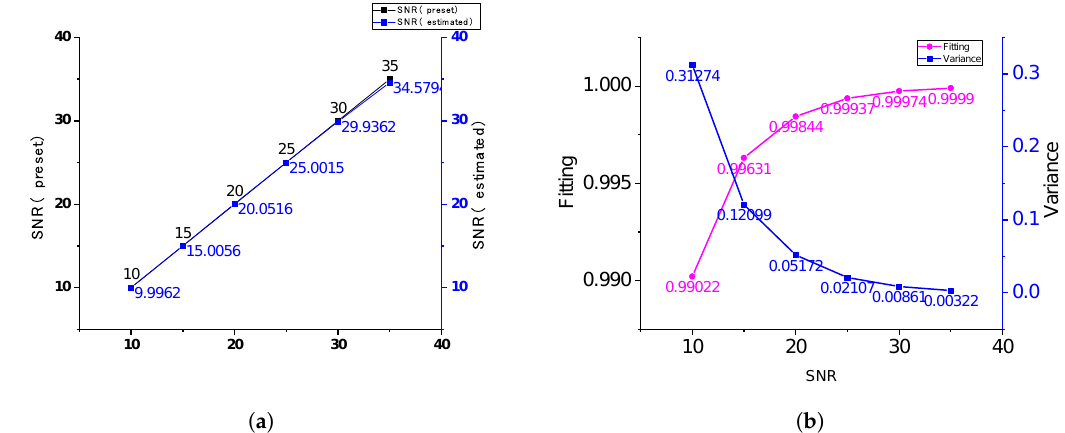
Figure 4. Algorithm simulation results. ( a ) Noise estimated result; ( b ) noise suppression results under different